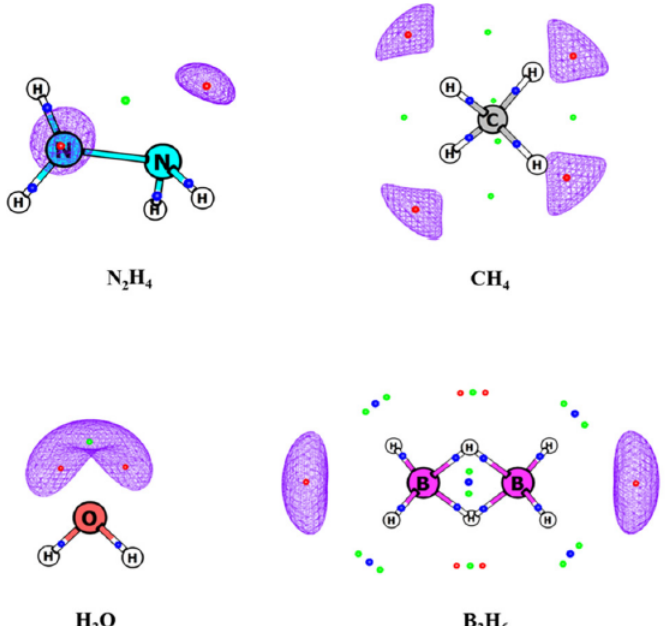
Figure 1. MESP topology of some molecules obtained from B3LYP/6-311G (d, p) calculations. Blue, green and red dots correspond to (3, − 1), (3, +1) and (3, +3) critical points (CPs). Blue dots on the bonds are (3, − 1) bond CPs. Isosurface values are − 60, − 2, − 50 and − 4 kcal/mol for N 2 H 4 , CH 4 , H 2 O, and B 2 H 6 ,